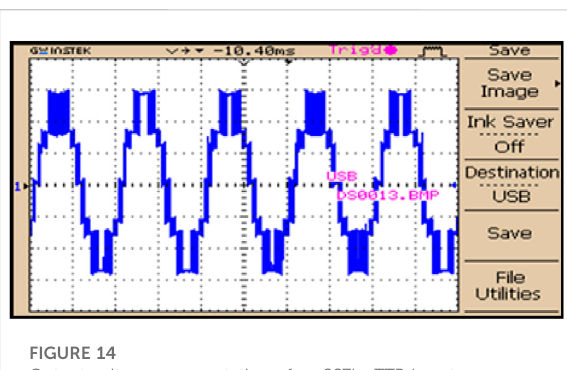
FIGURE 14 Output voltage representation of an 8S7L- TTB